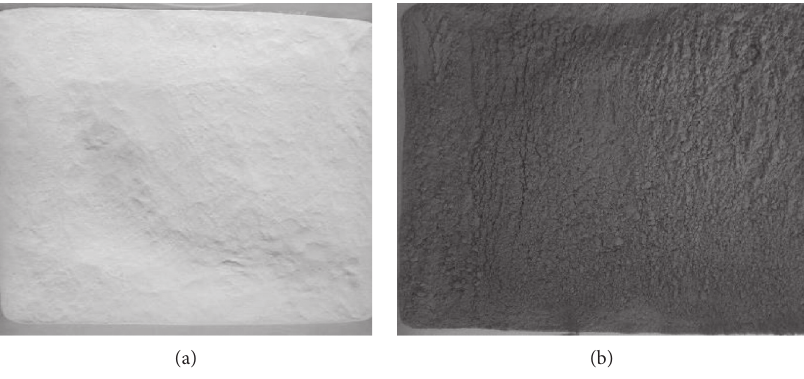
Figure 1: Images of (a) coral mud and (b) Taizhou soil.